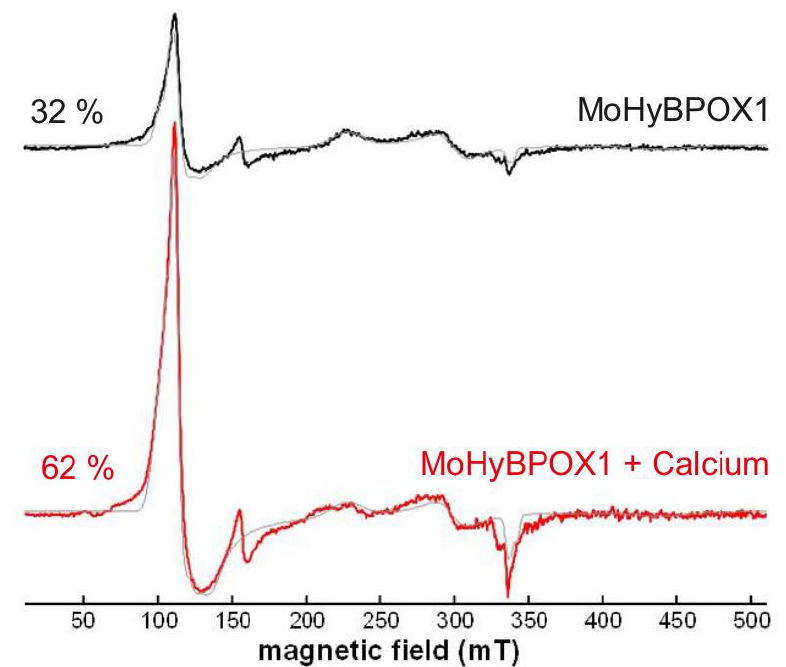
Figure 5. Electron paramagnetic resonance (EPR) profile of M. oryzae hybrid B peroxidase 1 in the ferric state showing a difference between sample of highly purified MoHyBPOX1 saturated with calcium ions (lower spectrum in red) and a comparable sample without calcium treatment (upper spectrum in black). The calculated content of high spin iron in the prosthetic heme group is presented on the left side of the diagram.